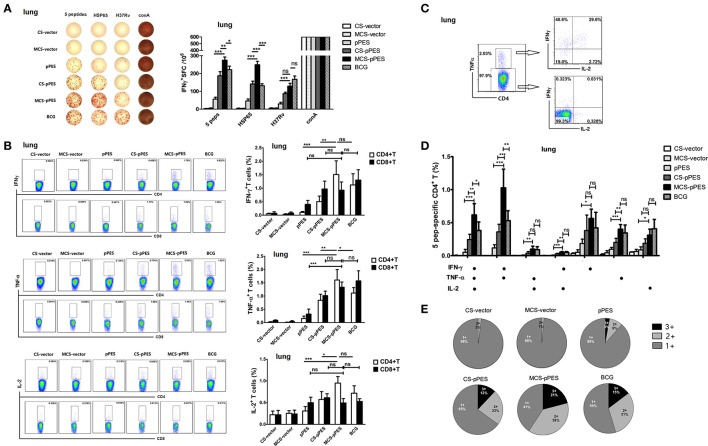
MCS-pPES intranasal immunization enhanced a poly-functional Th1 response in the lung. (A) 2 weeks after final immunization, pulmonic lymphocytes were stimulated with mixed peptides plus anti-CD28 for 36 h, and specific IFNγ-producing T cell spots were determined by ELISPOT assay. A representative result was shown. Statistical results were from three independent experiments and presented as the mean ± SEM (n = 6). (B) The frequency of CD4 and CD8 T cells in the lung producing IFN-γ, IL-2, or TNF-α in response to mixed peptides was measured by FACS. Numbers in each quadrant indicate percentages of positive cells in CD4+ or CD8+ T population. Results are represented as mean ± SEM (n = 6) of three separate experiments. (C) CD4+TNF-α+ and CD4+TNF-α- cells within CD4+ T cells were further gated, and the expression of IFNγ and IL-2 was shown. (D) The total peptide-specific Th1 response within CD4+ T cells was defined as the number of cells expressing any combination of IFN-γ, TNF-α or IL-2. The average percentages for each subset are shown. Results are represented as mean ± SEM (n = 6) of three separate experiments. (E) The quality of the T cell responses in (C,D). Pie charts showed the fraction of total cytokine-response in the lung comprising any combination of IFN-γ, IL-2, or TNF-α. The percentages of cells producing three cytokines (triple positive), two cytokines (double positive) or one cytokine (single positive) within the total CD4+T cell response were shown from three independent experiments. *p < 0.05; **p < 0.01; ***p < 0.001; ns, not significant.